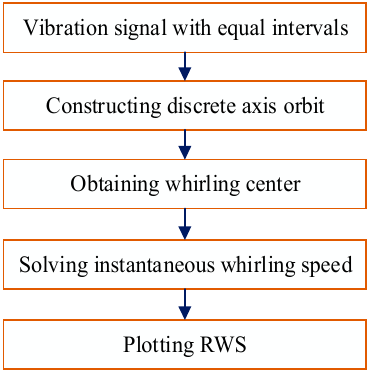
Figure 5. The plot diagram of relative instantaneous whirling speed (RWS).